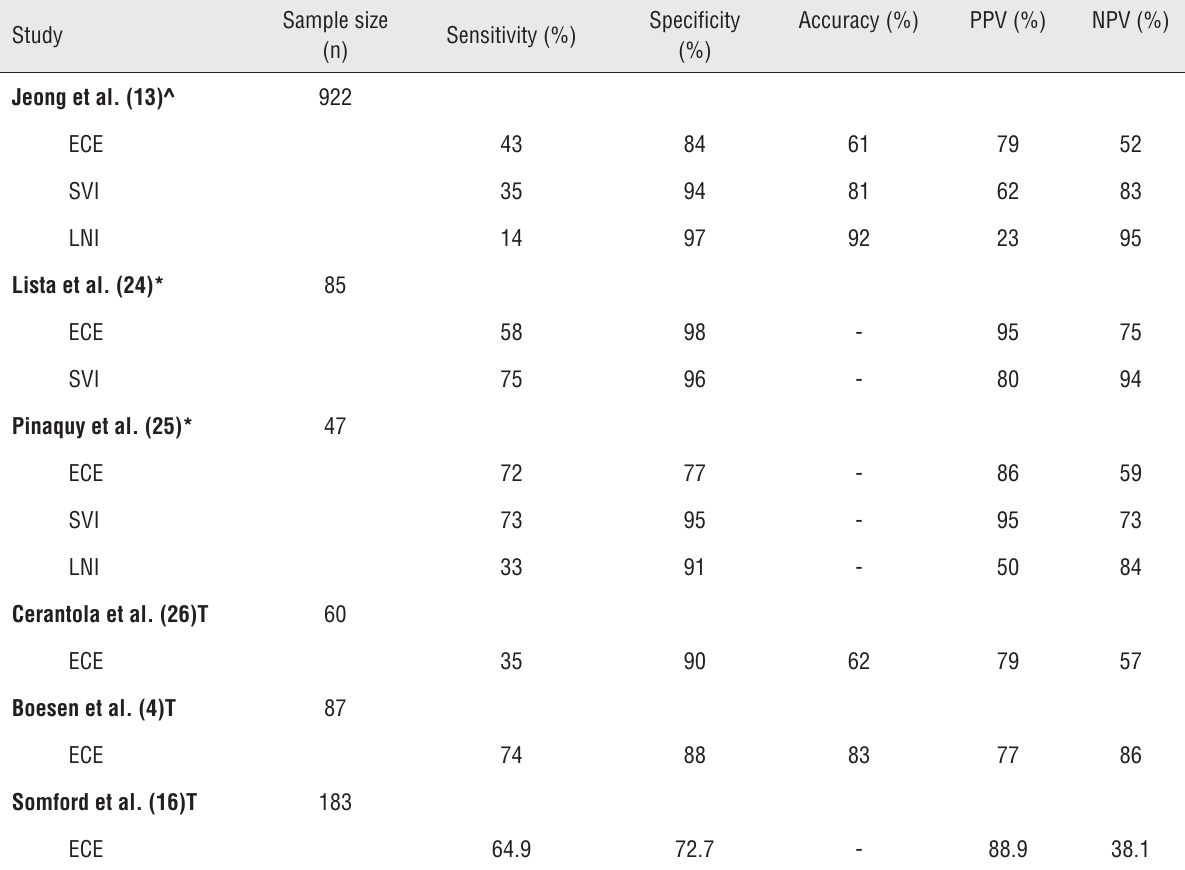
Table 2 - Comparison of operative characteristics of mp-MRI in high risk PCa for ECE, SVI, LNI compared to pathology